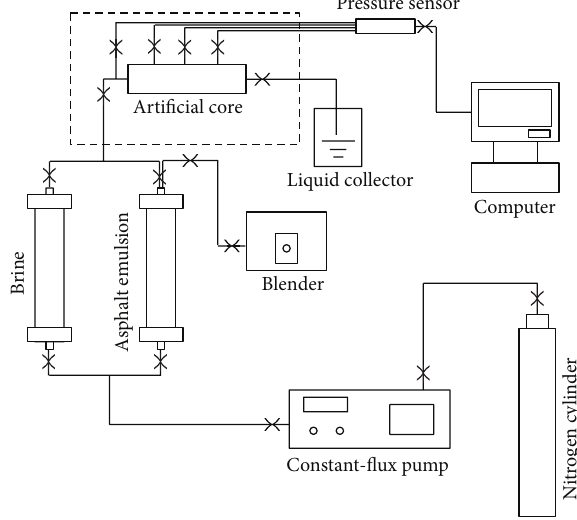
Figure 1: Experimental flow diagram.